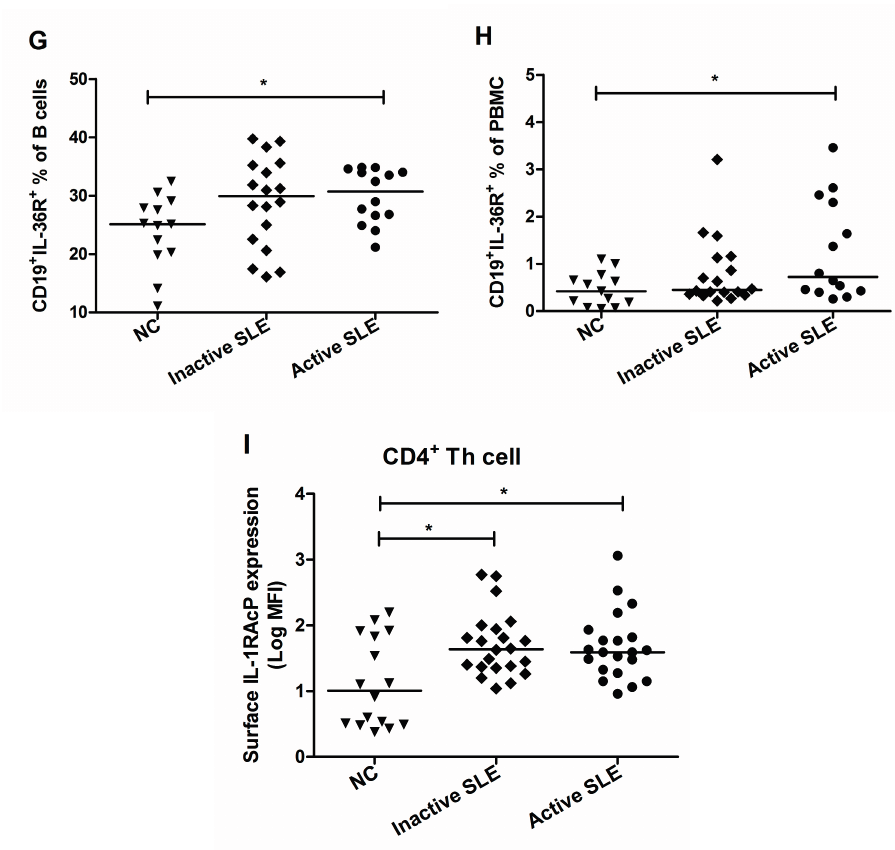
Figure 3. Expression profile of IL-36 receptors on the surface of immune cells. ( A – C ) Representative histograms of IL-36R expression on CD19 + B cells, CD4 + Th cells and CD138 + plasma cells in SLE patients and NC; ( D – F ) Representative histograms of IL-1RAcp expression on CD19 + B cells, CD4 + Th cells and CD138 + plasma cells in SLE patients and NC; ( G – I ) The proportion of IL-36R + B cells in total B cells and PBMC from inactive ( n = 18), active ( n = 14) SLE patients and NC ( n = 13), and the expression level of IL-1RAcP on CD4 + Th cells from inactive ( n = 22), active ( n = 21) SLE patients and NC ( n = 16) were detected using flow cytometry. Results are presented as scatter plots with median of the proportion or mean fluorescence intensity (MFI) subtracting corresponding isotypic controls. Statistical significance indicated by * p < 0.05 when compared with NC (Mann-Whitney U